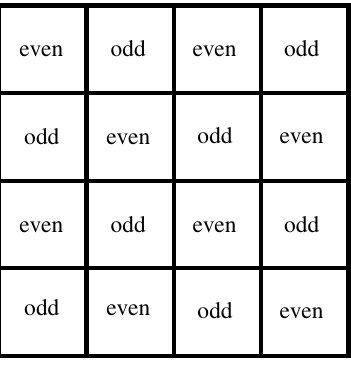
FIG. 3. We color the faces to “even” and “odd.” Each edge contains a qubit.